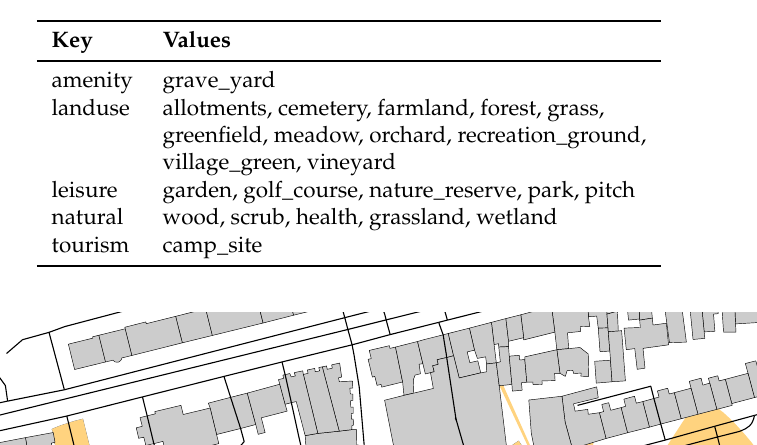
Table 2. OpenStreetMap tags considered to indicate green areas.